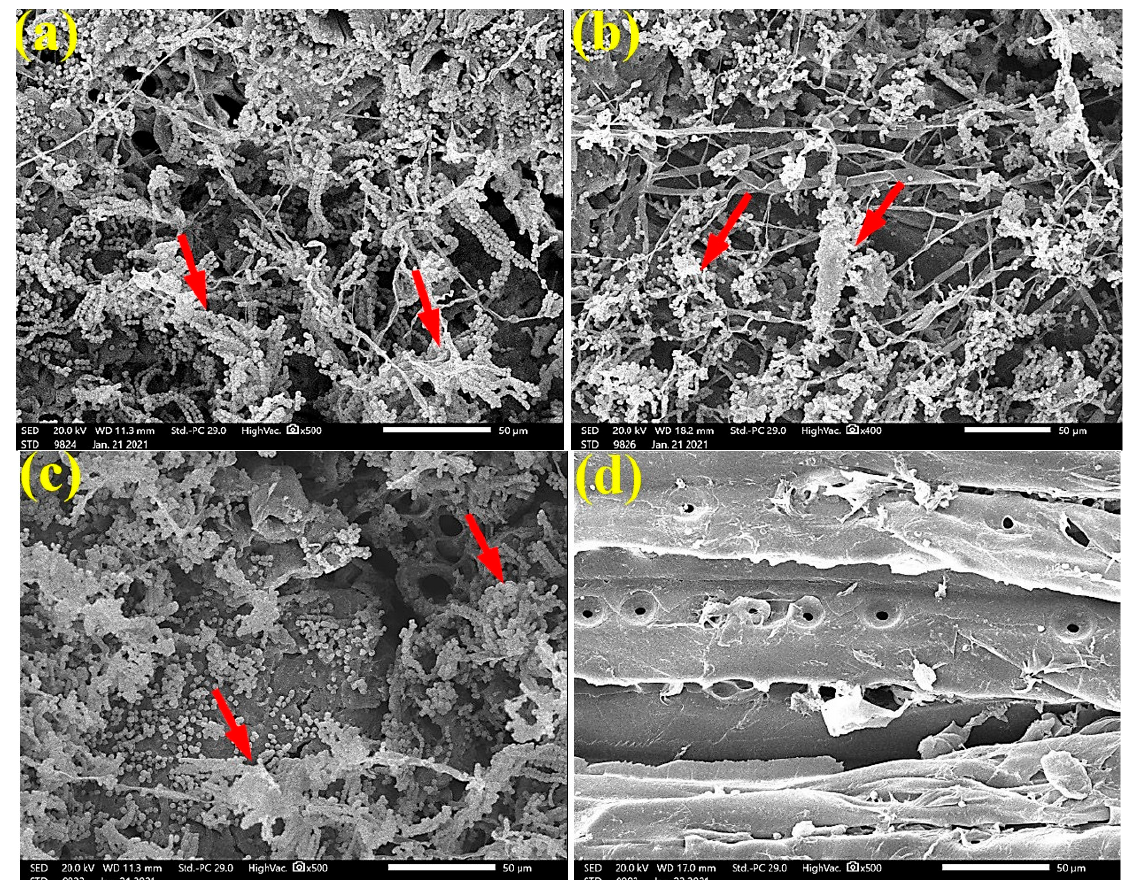
Figure 5. SEM images of P. roxburghii wood samples inoculated with Aspergillus fumigatus: ( a ) without treatment; ( b ) with 65 µL/mL C. reticulata EO; ( c ) with 65 µL/mL M. longifolia EO; ( d ) with 125 µL/mL M. longifolia EO. Arrows refer to the dense growth of fungal mycelia in wood samples, according to